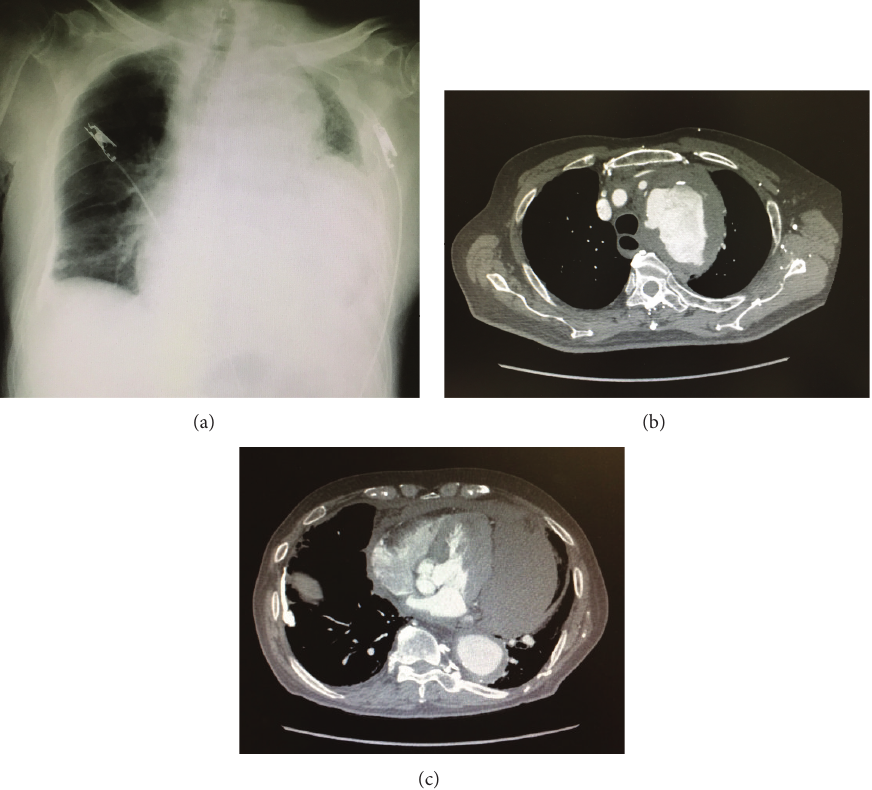
Figure 1: (a) A plain radiograph of the patient’s chest revealed a massive left pleural effusion. (b) and (c) Contrast-enhanced computed tomography revealed the presence of an aortic arch aneurysm surrounded by a hematoma, as well as extravasation of contrast media. The hematoma spread from around the aorta towards the